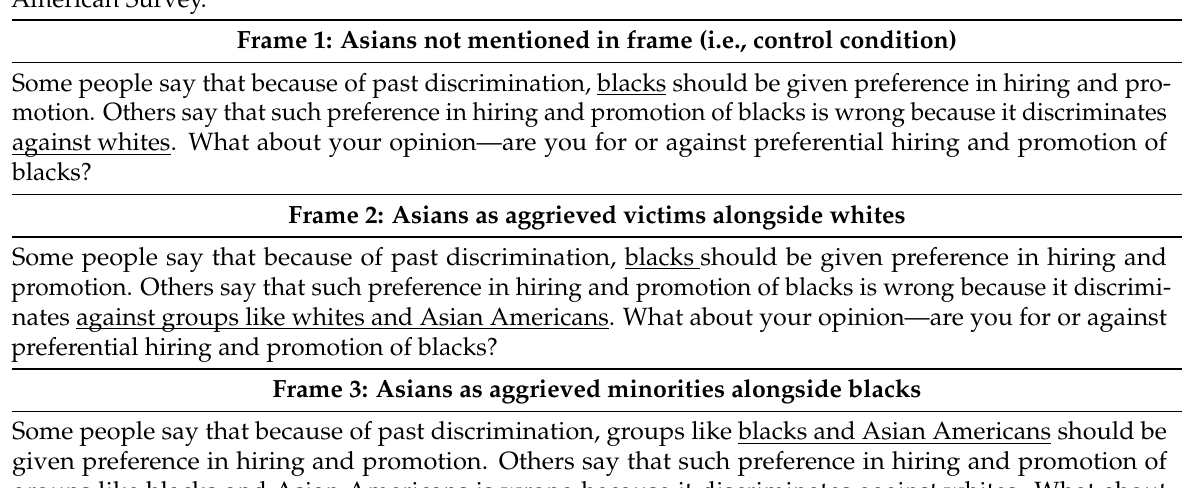
Table 1: Three-way framing experiment of preferential hiring and promotion. Source: 2016 National Asian American